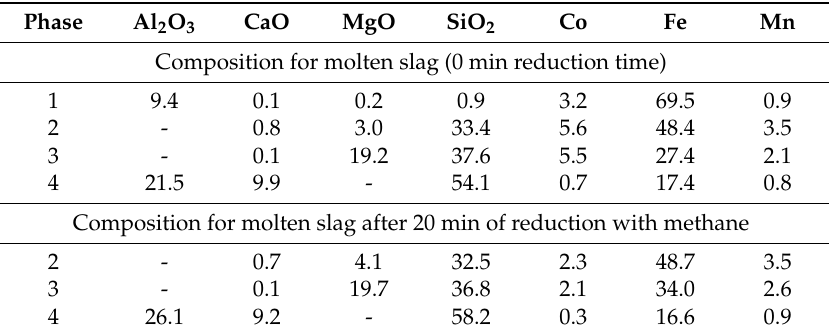
Figure 4. Microstructures of solidified samples with LiCoO 2 –MnO additives. ( A ) General overview after 5 min of reduction; ( B ) slag before reducing conditions (0 min) with marked phases 1–4; ( C ) slag after 2.5 min; ( D ) slag after 20 min. Table 4. Average concentrations (wt %) of elements in phases 1–4 seen in Figure 4B,D. Stable oxide formers have been converted into oxides.